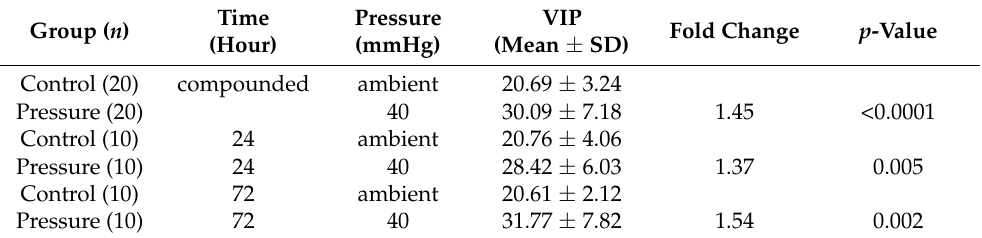
Table 1. VIP chor concentration after incubation at the ambient pressure (control) and 40 mm Hg for 24 h and 72 h: mean VIP chor level (pg/ug total protein) and standard deviation; n —sample size; Chicken VIP Peptides ELISA Kit, WUHAN EIAAB SCIENCE CO., LTD, Wuhan, China, was